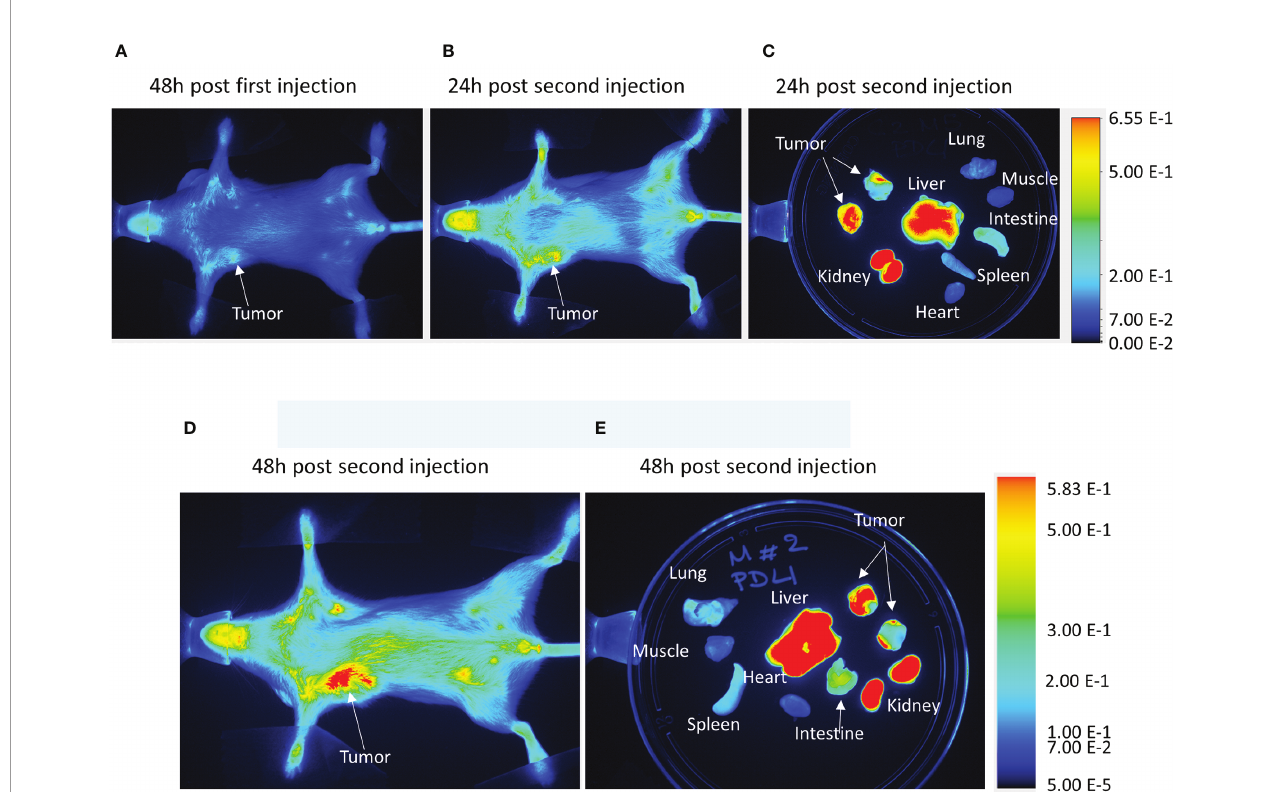
FIGURE 2 | In vivo PD-L1 siRNA dextran NP biodistribution. Representative in vivo images acquired from an orthotopic MDA-MB-231 tumor bearing mouse (A) 48 h after the fi rst injection of PD-L1 siRNA dextran NPs, (B) 24 h after a second injection of PD-L1-siRNA-dextran NPs, and (C) the corresponding ex vivo images. Representative in vivo images acquired from an orthotopic MDA-MB-231 tumor bearing mouse (D) 48 h after a second injection of PD-L1-siRNA-dextran NPs and (E) the corresponding ex vivo